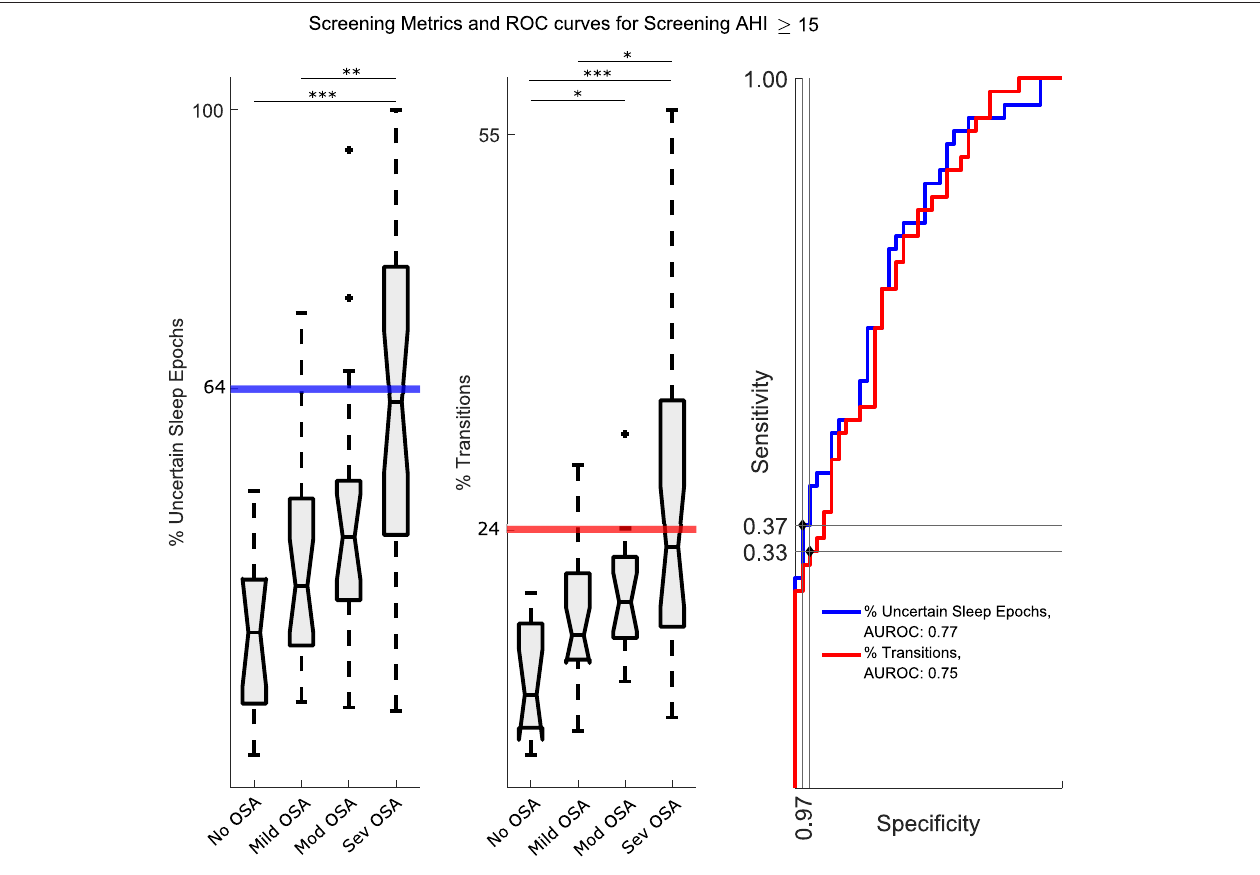
FIGURE 4 | Left and Middle: The distribution of % Uncertain Sleep Epochs and % Sleep Wake Transitions for No, Mild, Mod and Sev . The increasing trends supported the application of the metrics for detection of OSA patient (i.e., with an AHI > 15). The thick lines represent the chosen thresholds. The level of statistical significance is marked with one asterisk (*) if p < 0.05, two (**) if p < 0.01, and three (***) if p < 0.001. Right: Separate ROC curves for both metrics. Indicated dots were the chosen operating points and the corresponding thresholds are indicated on the left plots. For % Uncertain Sleep Epochs, an operating point on the ROC curve was chosen where the specificity was > 95%, since a larger specificity for OSA patient detection was preferred. As such, a threshold of 64% was selected, at which specificity reached 97% and sensitivity 37%. For % Sleep Wake Transitions a threshold of 24% was selected, at which a specificity of 95% and sensitivity of 33% was obtained. AUROC, Area Under the ROC